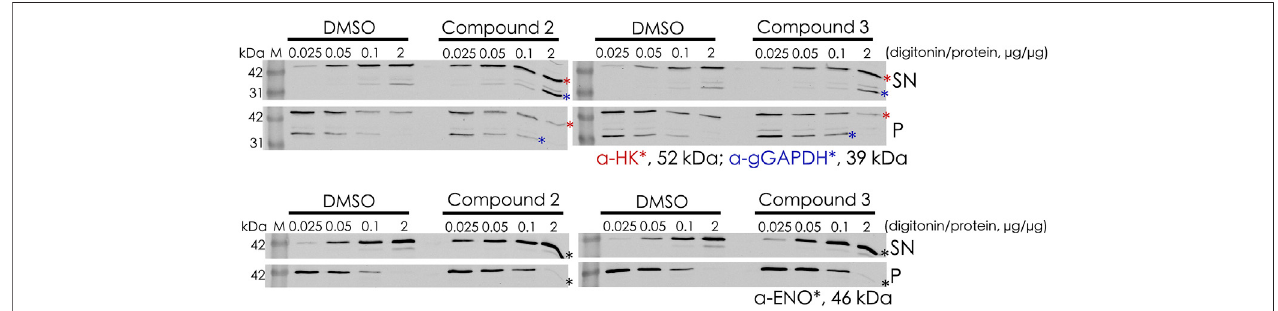
FIGURE 8 | Digitonin fractionation of compound 2 – and compound 3 – treated BSF cells. Digitonin-solubilized fractions are indicated as supernatant (SN), and the non-solubilized fractions are indicated as pellet (P). Four concentrations of digitonin treatment were used to investigate the mislocalization of matrix proteins, and hexokinase (HK) and glyceraldehyde 3-phosphate dehydrogenase (gGAPDH) are labeled with red and blue asterisks, respectively (upper panel) . Enolase (ENO) as the cytosolic marker is indicated by a black asterik (lower panel) . At the lowest level ofdigitonin treatment (0.025 μ g of digitonin/ μ g of total protein), HK and gGAPDH were released from compound-treated cells to a greater extent than from the corresponding DMSO control cells, indicating mislocalization of these proteins to the cytosol upon treatment.